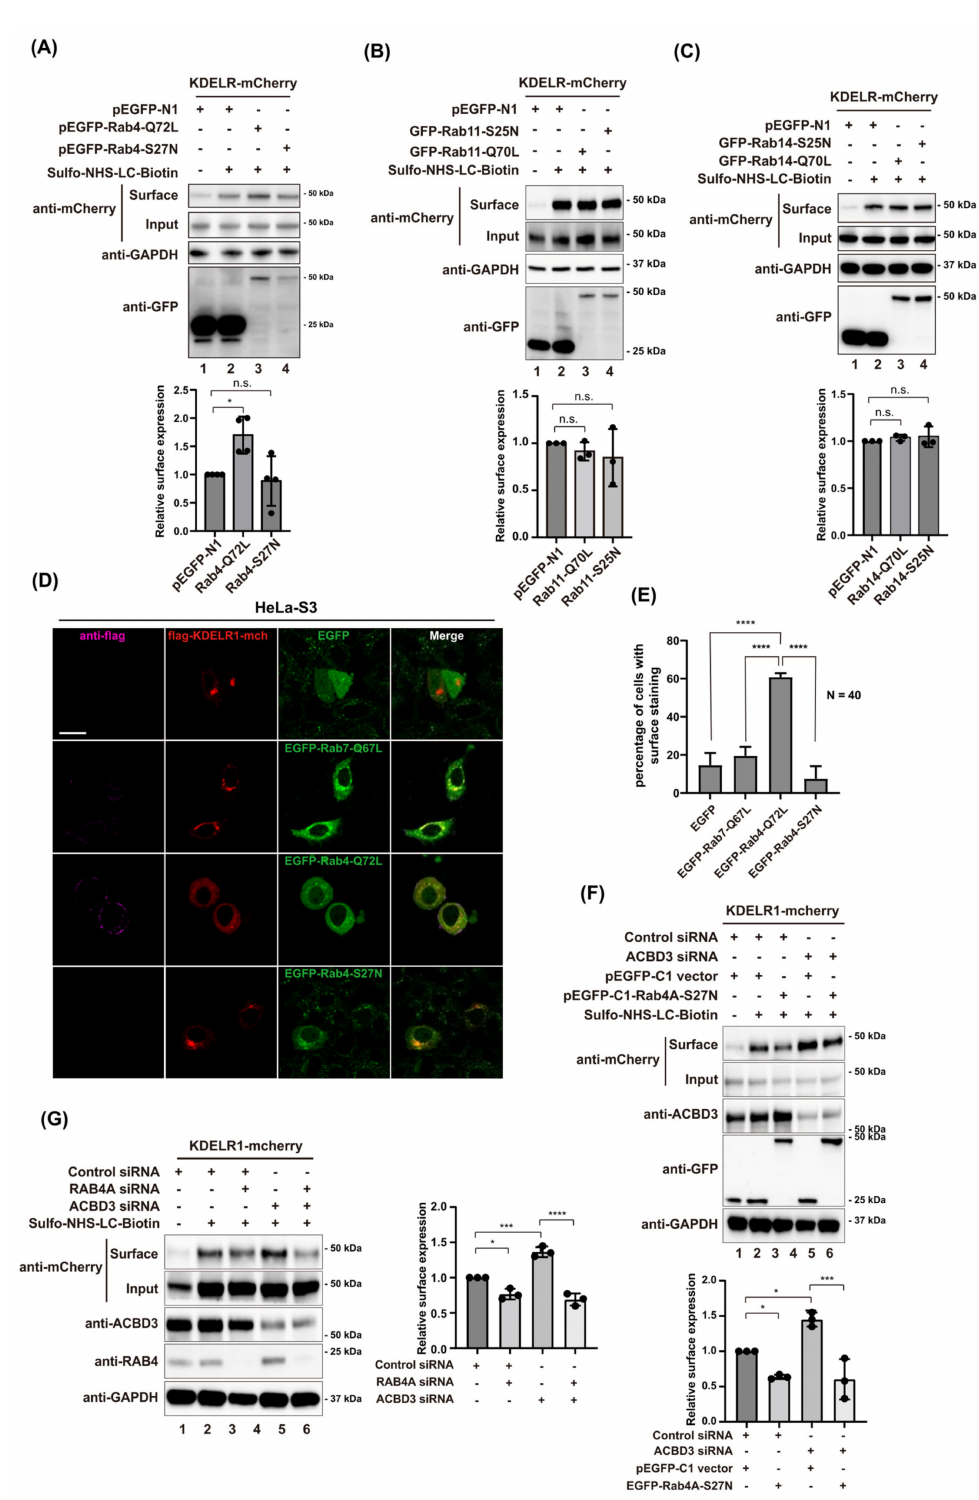
Figure 5. Rab4A plays a crucial role in the cell surface expression of KDEL-R1. ( A – C ) The cell surface expression of KDEL-R1-mCherry is significantly increased in HT1080 cells when overexpressing the constitutive active mutant Rab4A-Q72L, but not Rab11A-Q70L or Rab14A-Q70L, compared to the control cells. HT1080 cells were transfected with KDEL-R1-mCherry and indicated Rab plasmids